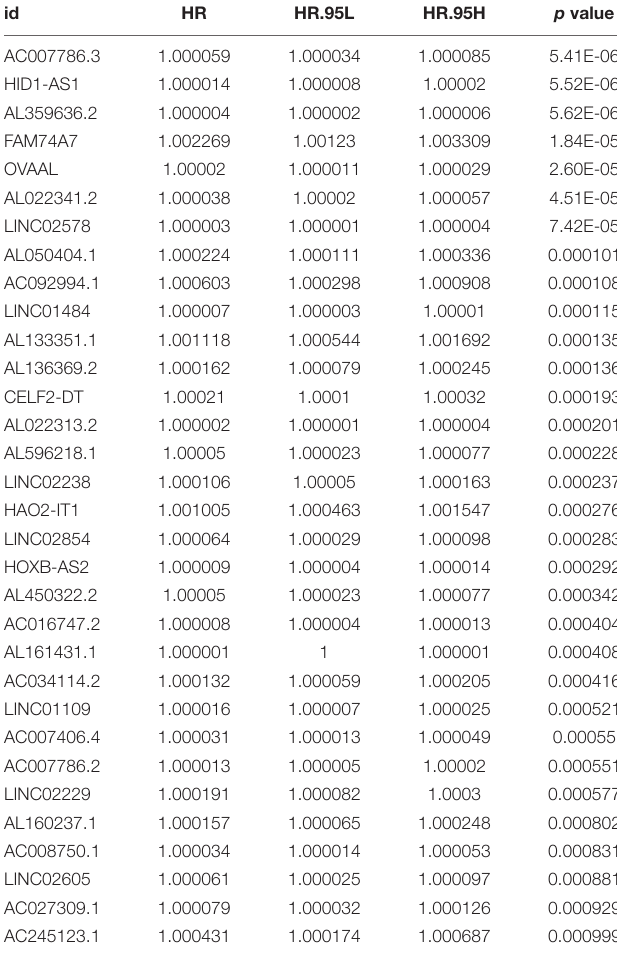
TABLE 1 | The 32 immune-related lncRNAs with a significant prognostic